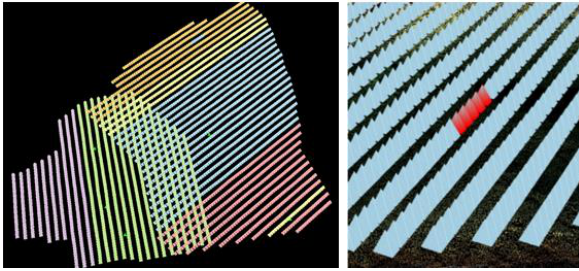
Fig. 6: Visualization of larger blocks: Colors separate sub- blocks (left) and mark up weak parameters